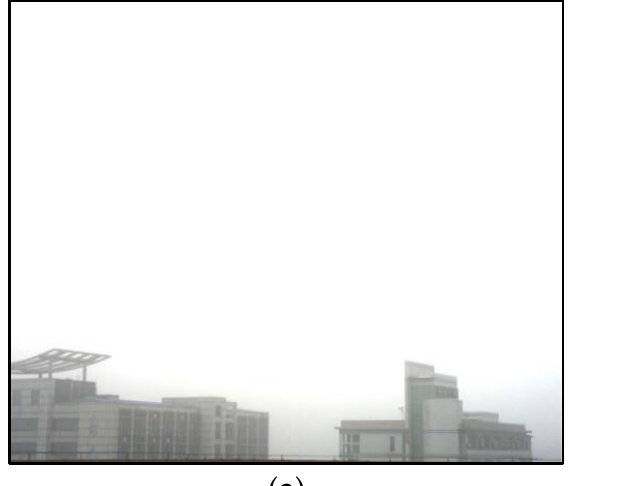
( b ) dehazed image.